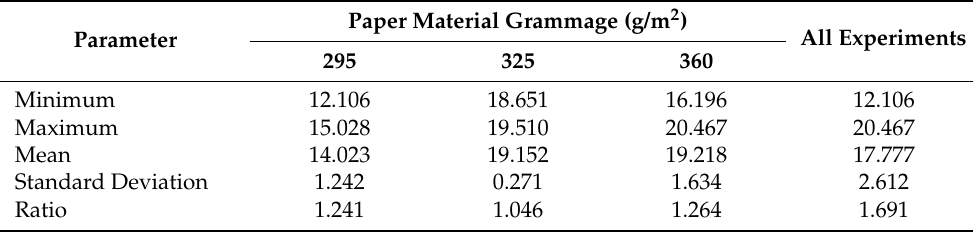
Table 4. Descriptive statistical parameters of experimental tensile strength results.